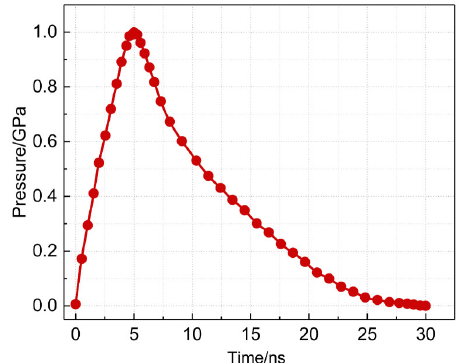
Figure 2. Pressure curve of laser shock wave loading.